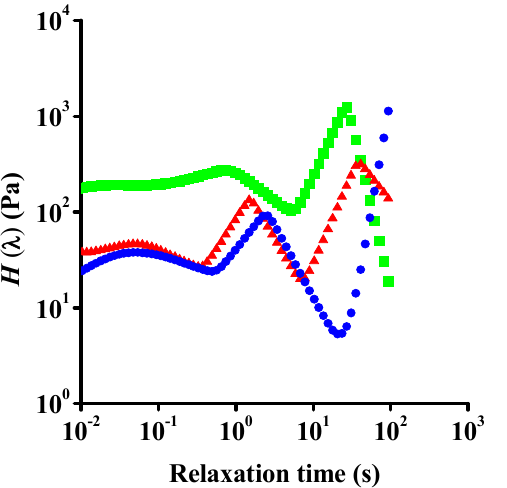
Figure 11. Relaxation process of aqueous GO suspensions of different ages. 0 y—blue dots; 1 y— red triangles; 2 y—green squares.